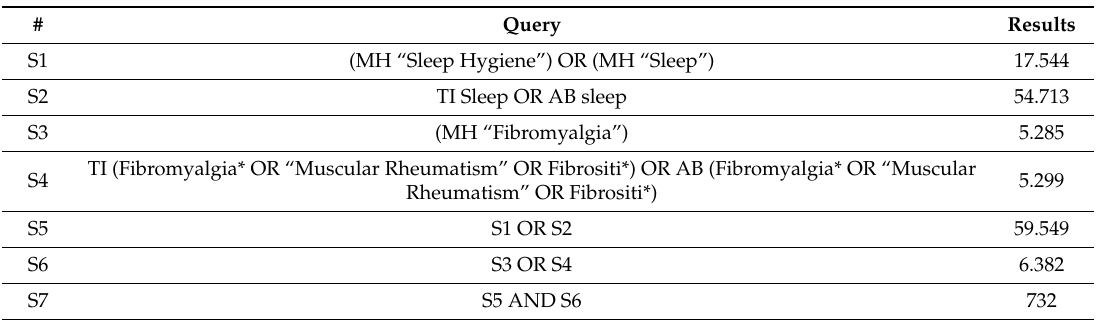
Table A1. CINAHL